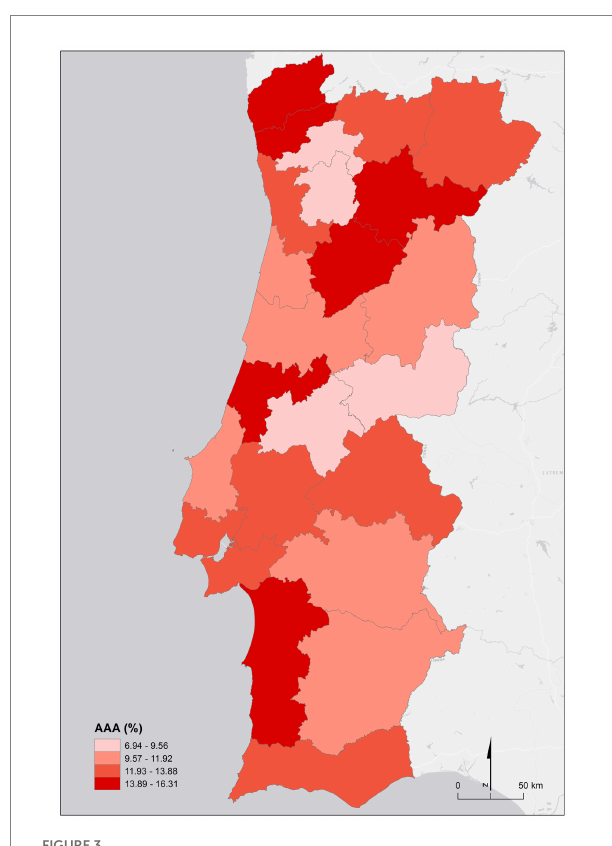
FIGURE 3 Active aging awareness acores by NUTS III (standard deviation).